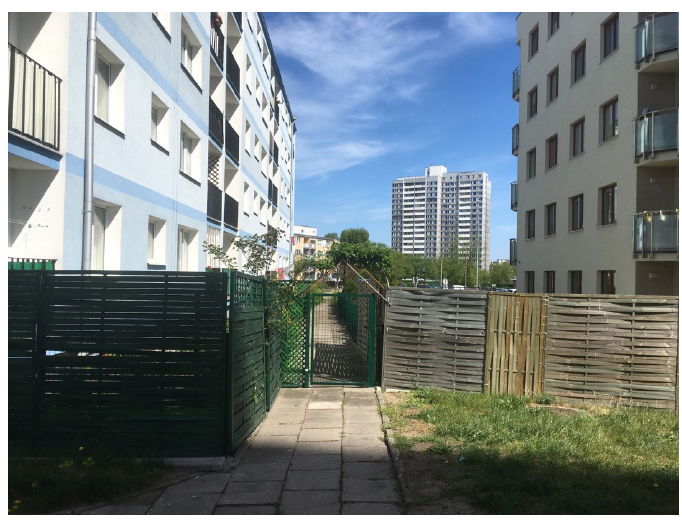
Figure 1: The divided landscape of exclusionary commoning after socialism: fencing between old and new residential developments in Przymorze Małe, Gdańsk